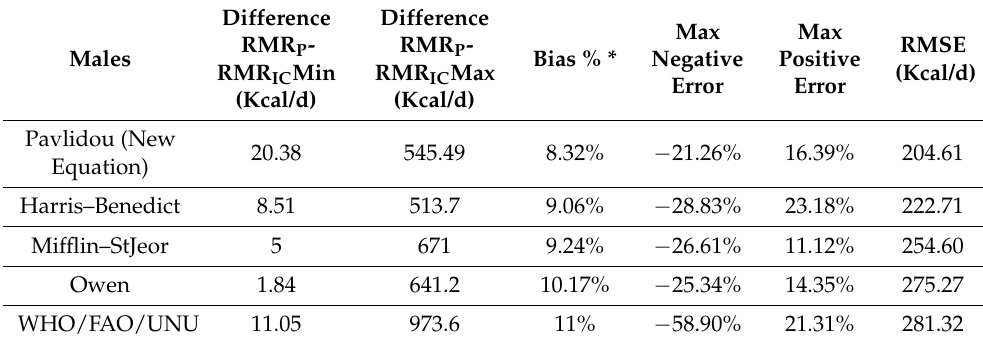
Table 3. Evaluation of selected predictive equations in 40 men based on differences Predicted (RMR P )-Measured (RMR IC ), percentage of accuracy, Bias, and Root Mean Square Error.